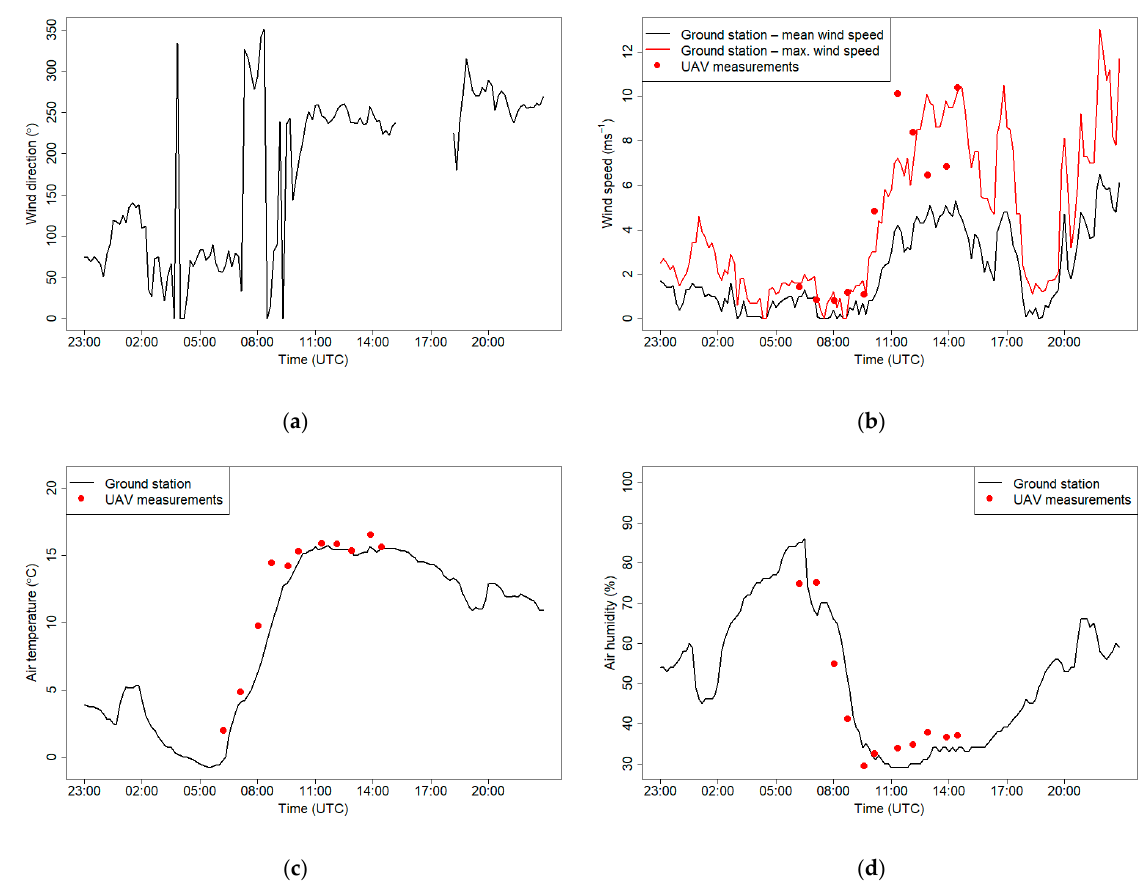
Figure 19. Wind direction ( a ), wind speed ( b ), air temperature ( c ) and relative humidity ( d ) measured at the JU Campus meteorological station on 7 March 2019. Red dots show measurements from the drone made at the start of each flight.